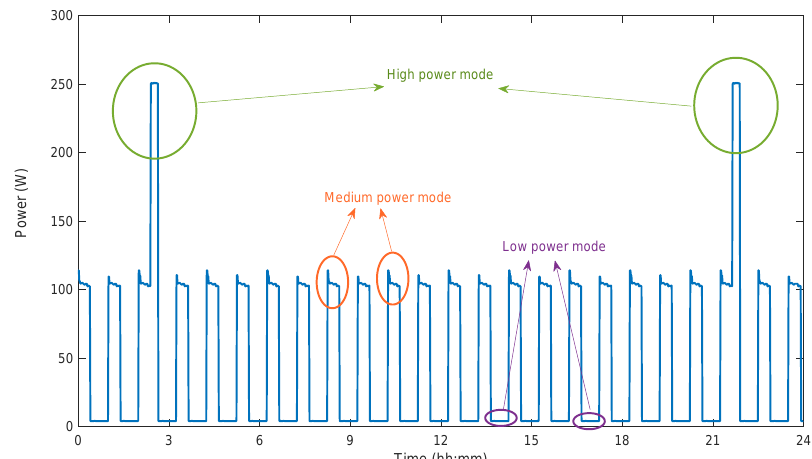
Figure 8. Power profile of a